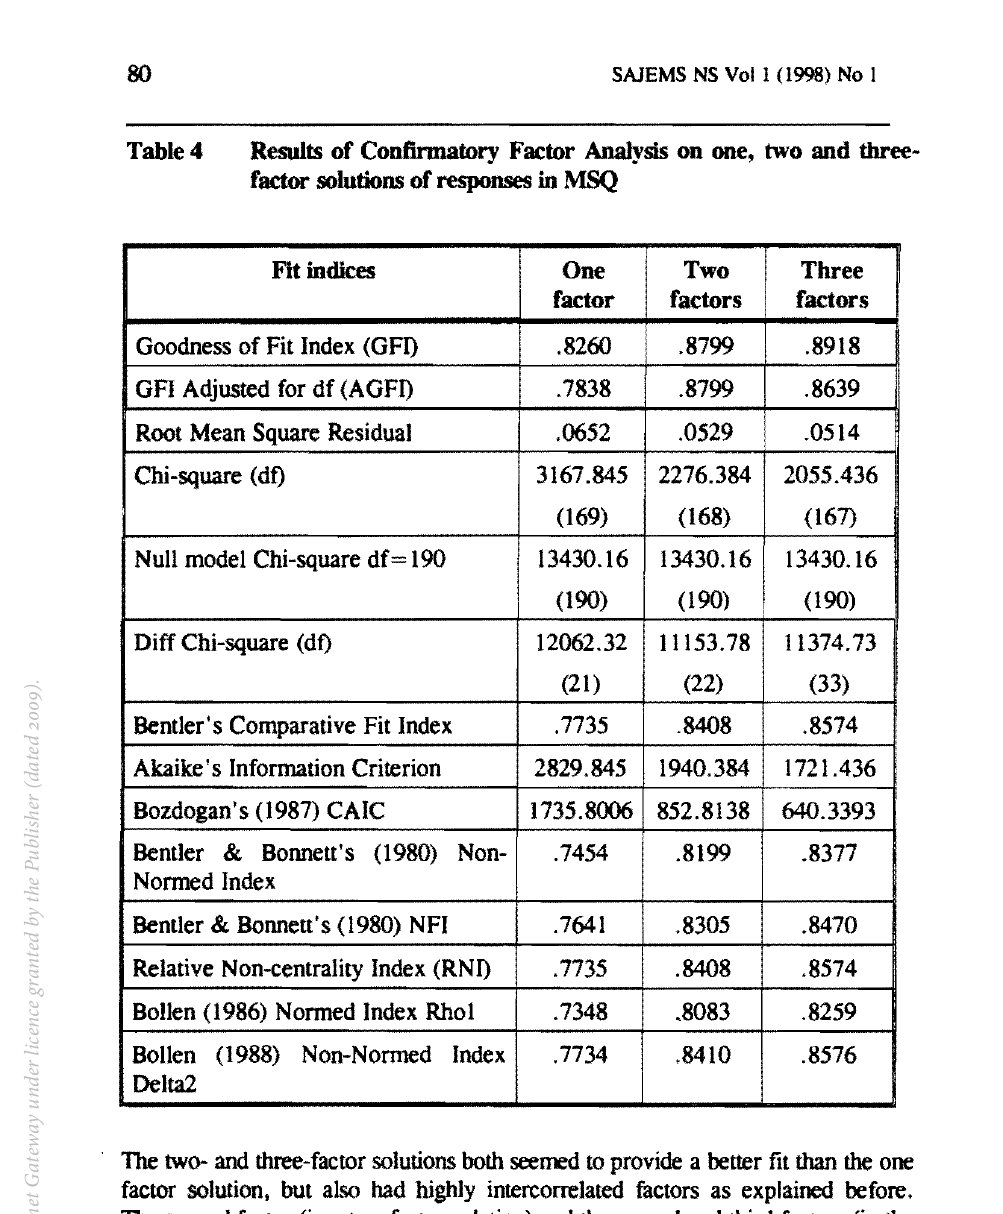
Results of Confirmatory Factor Analysis on one, two and three factor solutions of responses in